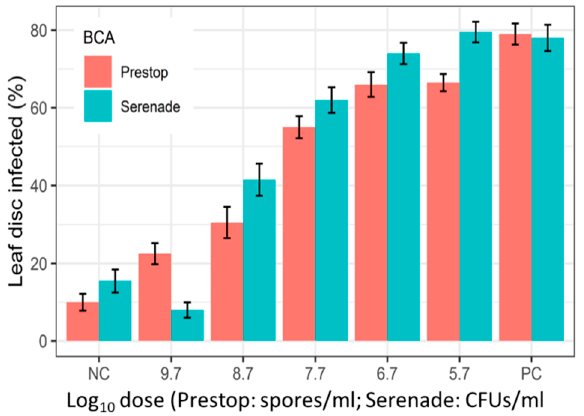
Figure 4. Overall percent L. sativa leaf disc infected with B. cinerea when post-inoculation challenged with two formulated biocontrol products (Prestop and Serenade) at a number of doses in a glasshouse at 17–22 °C with a RH range of 60–100%. NC: negative control (only sterile water was applied) and PC: positive control (inoculated with B. cinerea but not treated with BCA).